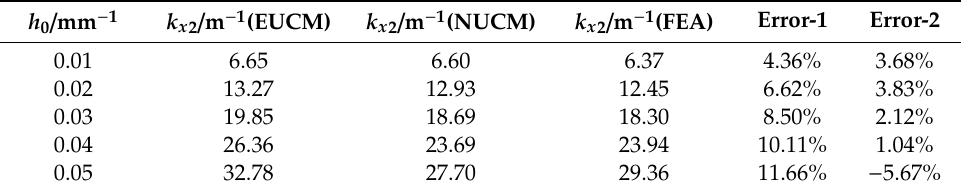
Table 5. Principal curvature of anti-symmetric cylindrical shells with di ff erent initial natural curvature from analytical model and simulation.